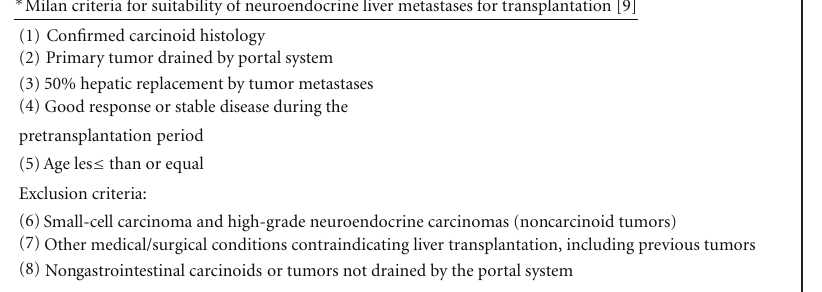
Figure 1: Proposed Algorithm for management of isolated neuroendocrine liver